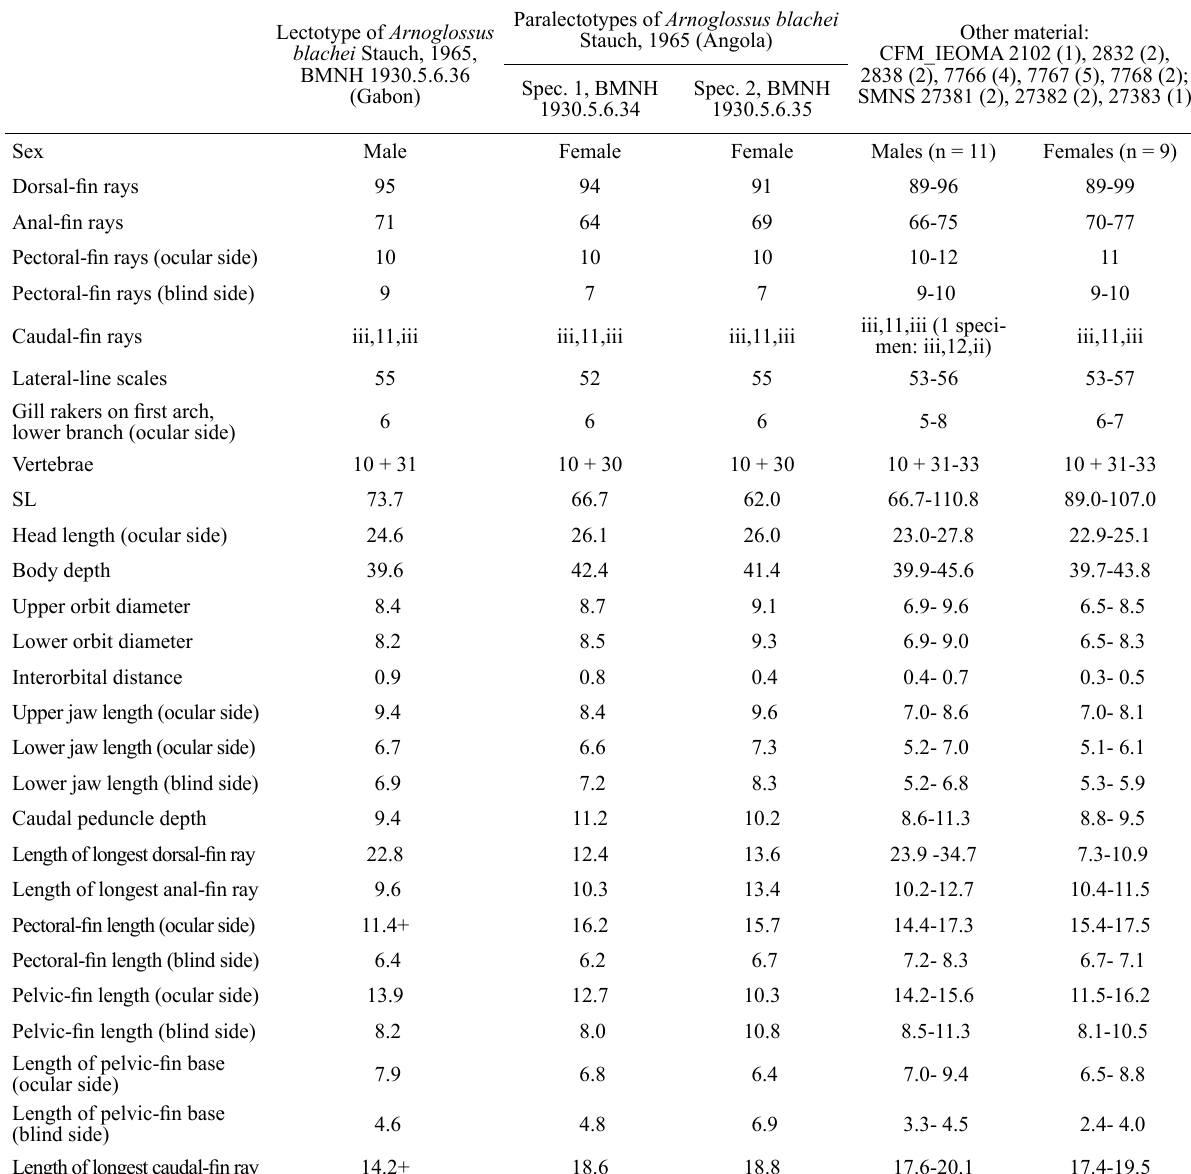
Table 3. – Counts and proportions [% of SL] of Arnoglossus blachei Stauch, 1965.